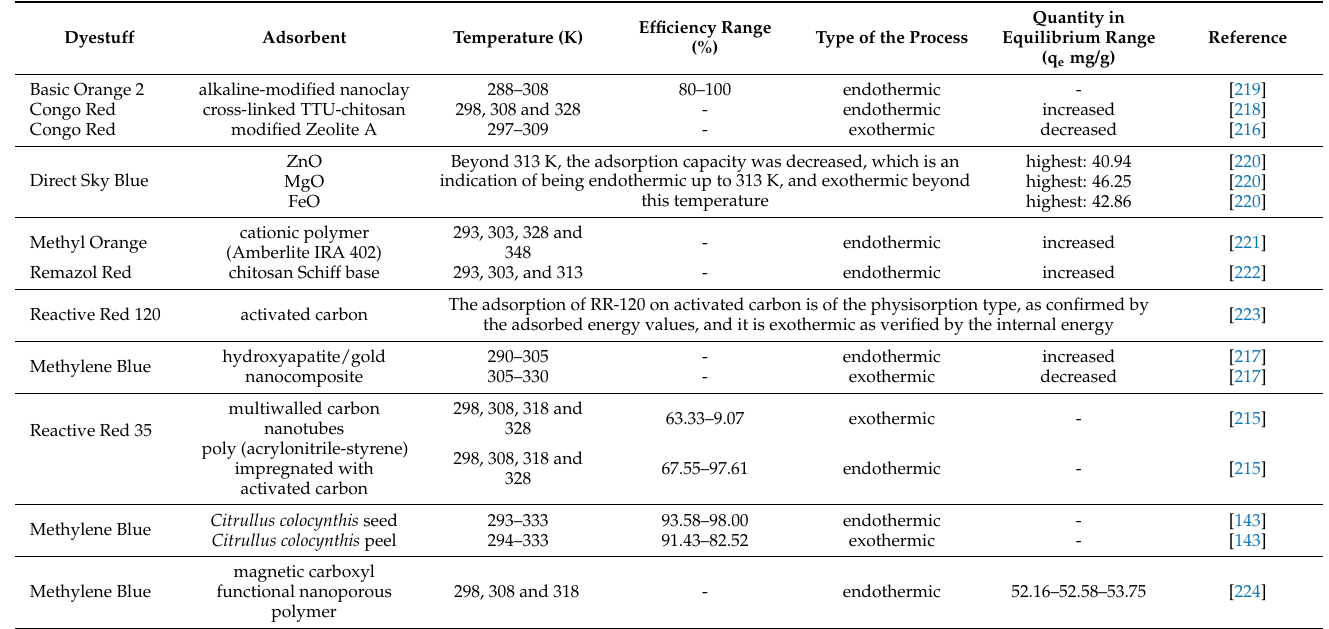
Table 5. Results of various research regarding the effect of